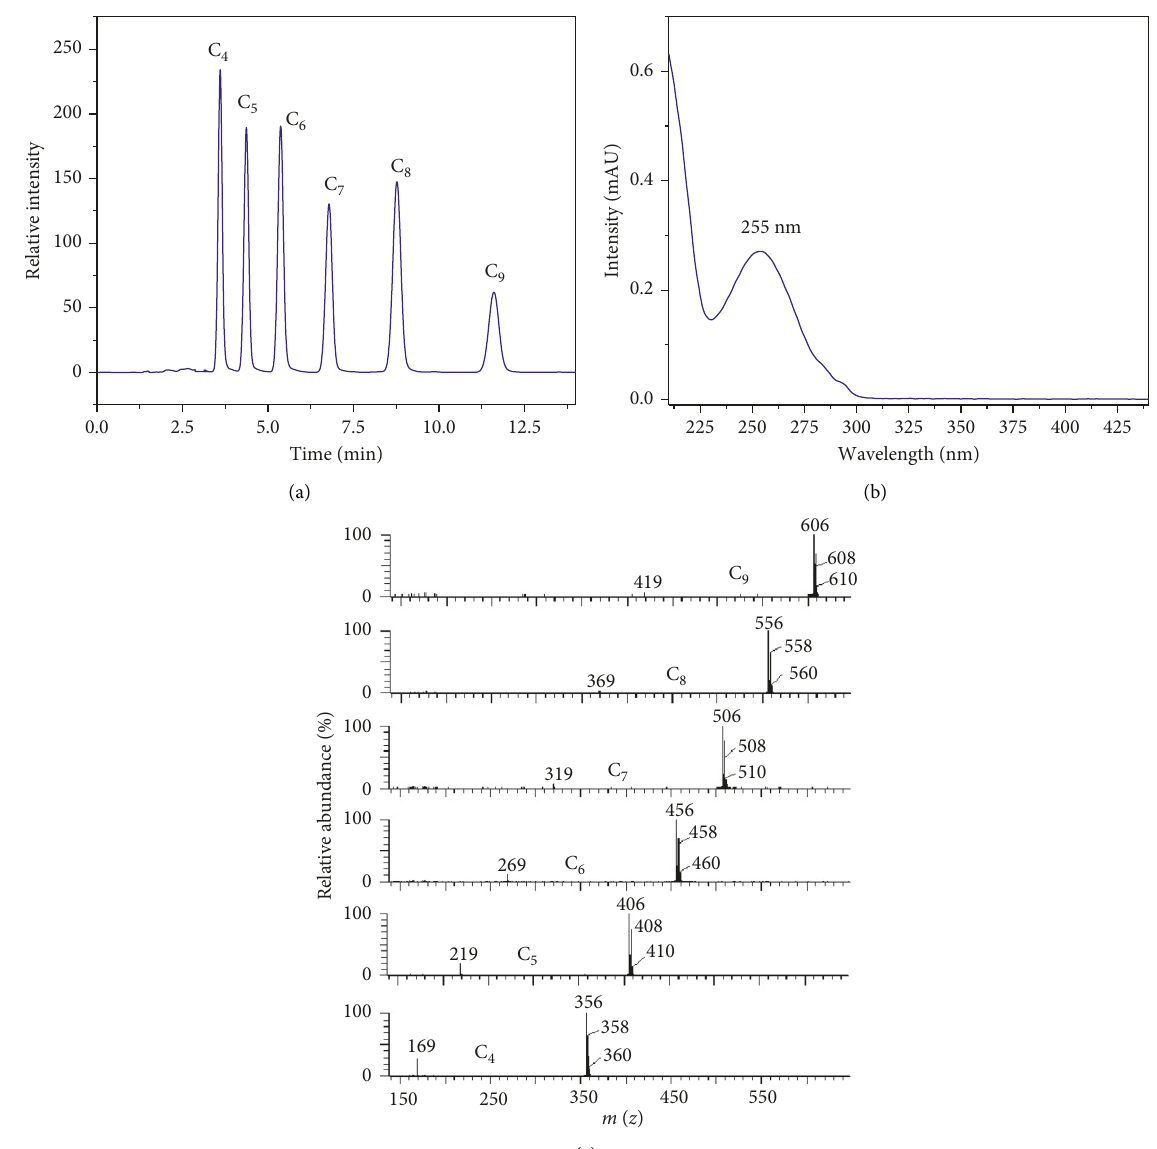
Figure 3: (a) LC chromatogram, (b) UV spectrum, and (c) mass spectra of PFCA-DCA